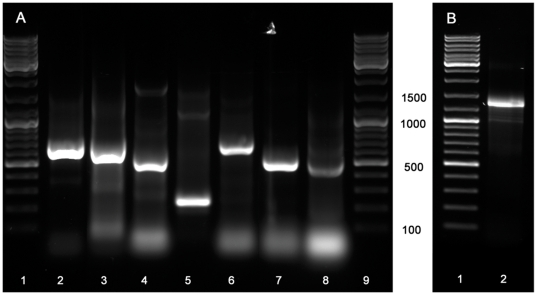
Degenerate PCR products from genomic DNA for the 7 putative Class A and Class C GPCR.
A) Lanes, 1 and 9_DNA ladder, 2_ Rm_α2AOR, 3_ Rm_Dop1R, 4_ Rm_β2AOR, 5_Rm_Dop2R, 6_Rm_INDR , 7_Rm_5HT7R, 8_Rm_mAchR. B) Lanes, 1 _DNA ladder, 2_ GABABR.